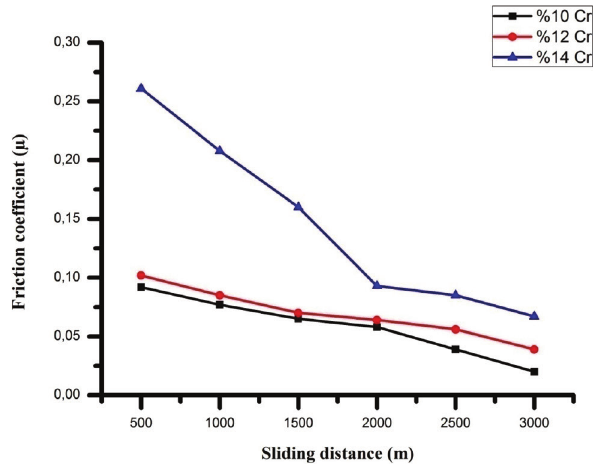
Fig. 6: Weight loss variations of high chromium white irons with different chromium contents under a load of 120 N